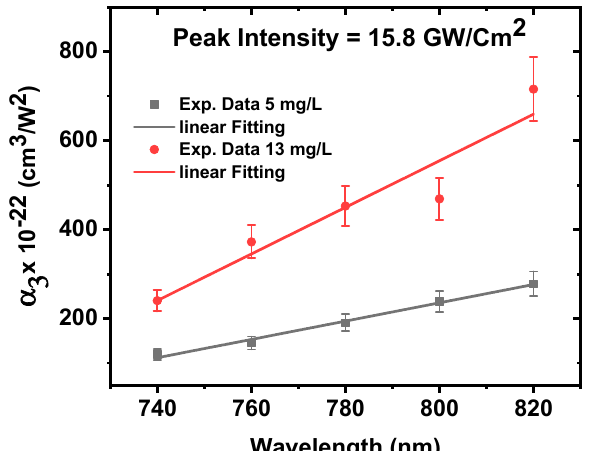
Figure 9. The 3PA coefficient of ZnONPs colloids as a function of excitation wavelength at a constant incident peak intensity of 15.8 GW/cm 2 .